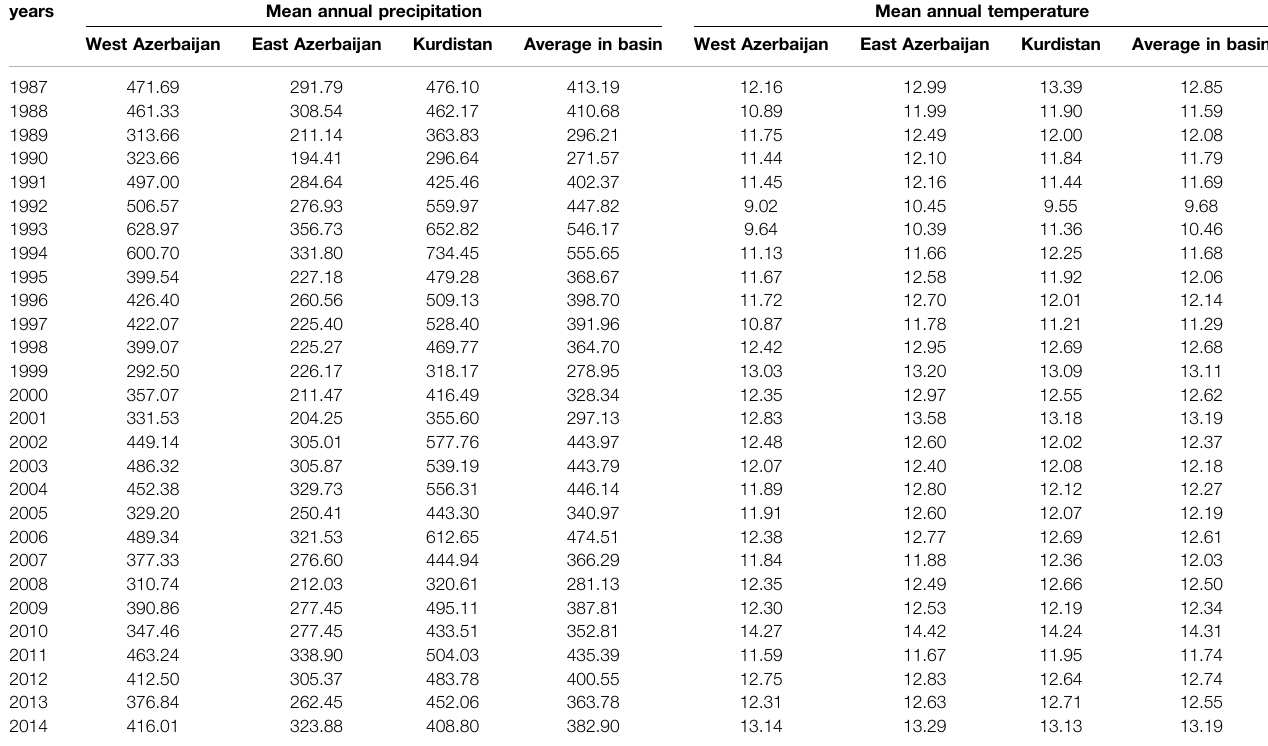
TABLE 4 | Mean annual Precipitation and mean annual temperature in LU basin (East Azerbaijan, West Azerbaijan and Kurdistan provinces) from 1987 to